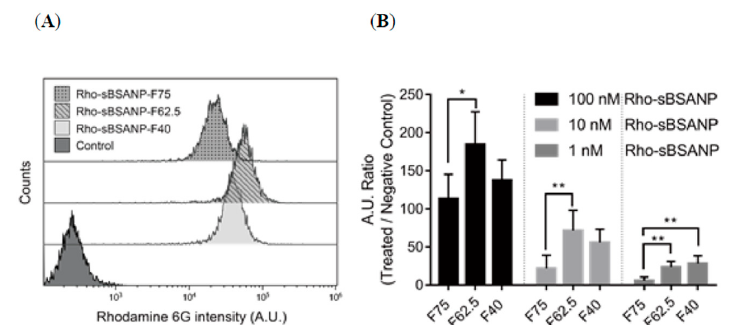
Figure 7. Flow cytometry measurement of MDA-MB-468 treated with Rho-sBSANP formulations for 4 h. ( A ) Number of cells with rhodamine detected and ( B ) qualitative analysis of Rho-sBSANP taken up by MDA-MB-468 at 100, 10, and 1 nM. * p < 0.05 was considered statistically significant. ** p < 0.01 was considered statistically significant.